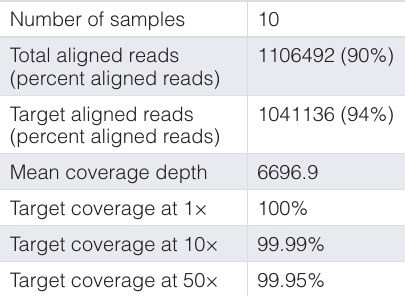
Table 2. Overall NGS